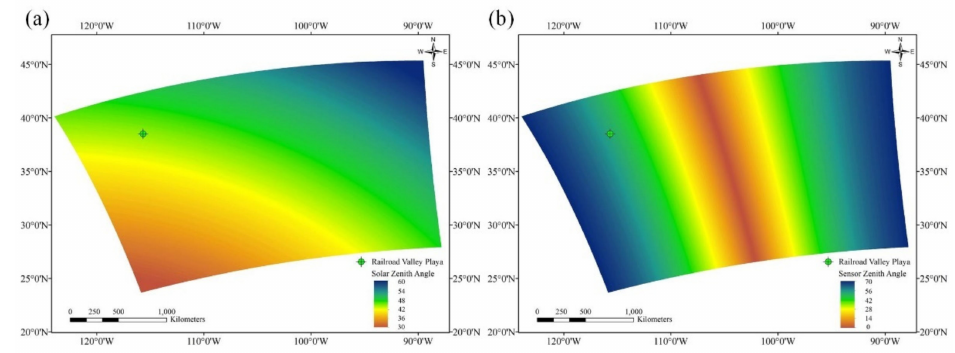
Figure 3. The illumination and observation geometries of FY-3D MERSI-II at Railroad Valley Playa site during overpass on 10 September 2019: ( a ) solar zenith angle; ( b ) sensor zenith